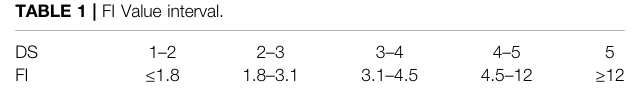
TABLE 1 | FI Value interval.